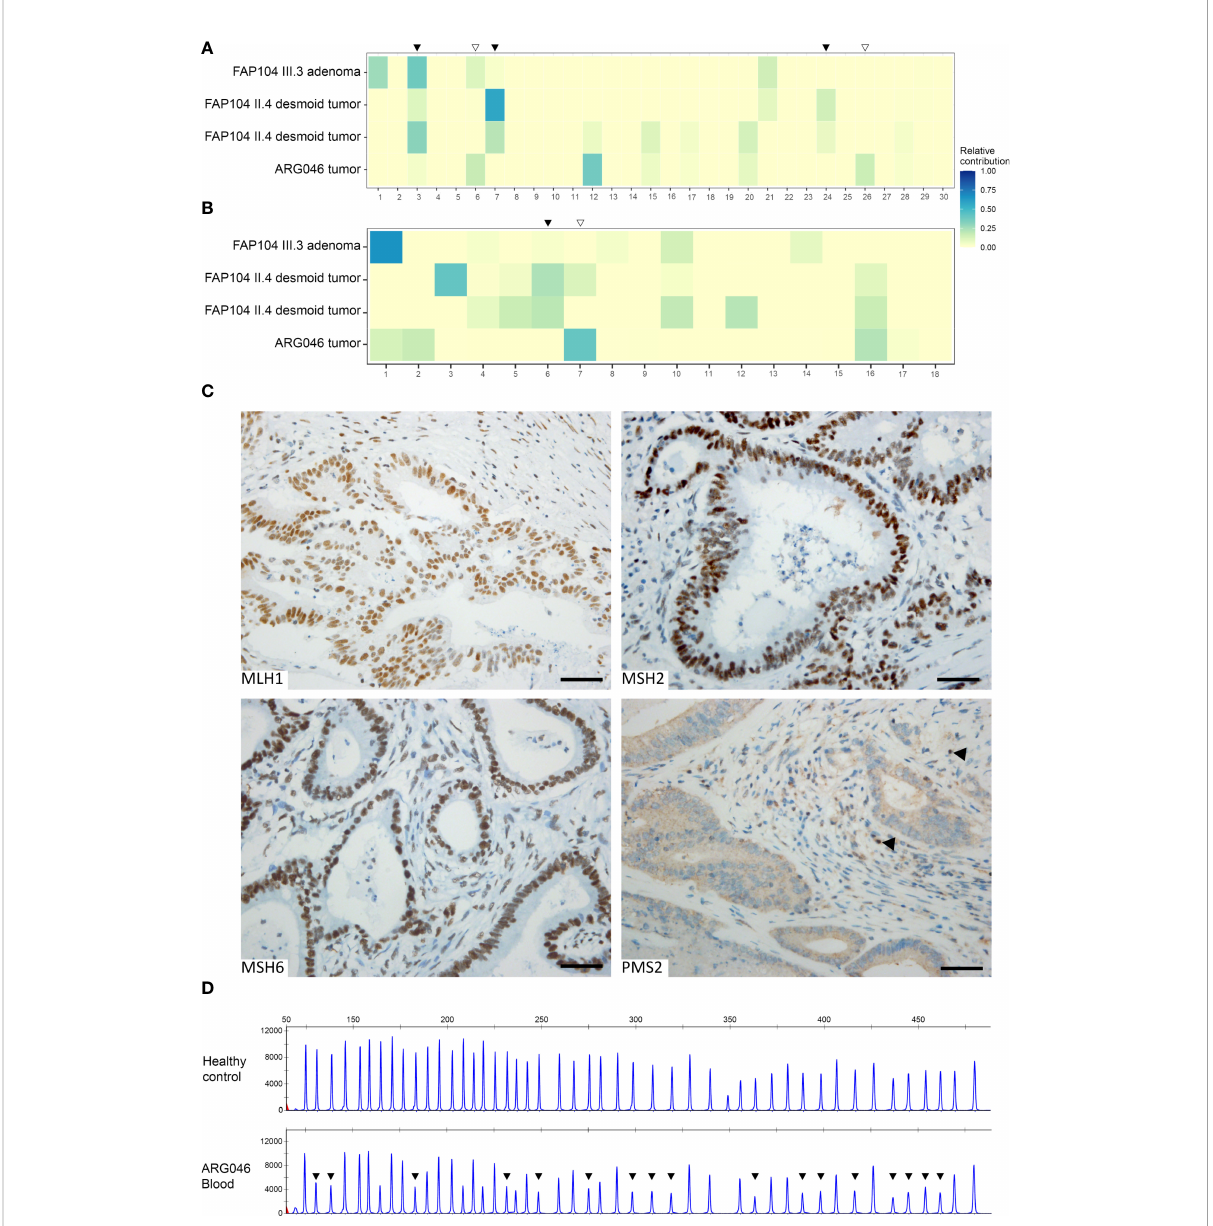
FIGURE 4 Somatic mutational signature analysis of four NEIL1 -associated tumors (A, B) . (A) Heatmap indicating the relative contribution of SBS signatures (COSMICv2) to the mutational landscape of each tumor. Black arrowheads indicate NEIL1- de fi ciency associated signatures prominent in tumors from FAP104, whereas open arrowheads represent MSI-signatures present in a colorectal carcinoma from ARG046. (B) Heatmap of the relative contributions of ID signatures (COSMICv3.1, GRCh37) to the mutational pro fi les of the tumors. Subsequent discovery of the PMS2 alteration in the ARG046 case (C, D) . (C) Immunohistochemical analysis of the MMR proteins reveals a selective loss of PMS2 in the tumor cells. Normal cells retaining the PMS2 expression are indicated with arrowheads. Scale bar represents 50 m m. (D) PMS2 -MLPA analysis of blood DNA of the ARG046 case as well as a healthy control. Arrowheads indicate reduced emission peaks at exons 2-11. The average probe ratios of exons 2-11 (0.54 ± 0.03) are indicative of a heterozygous